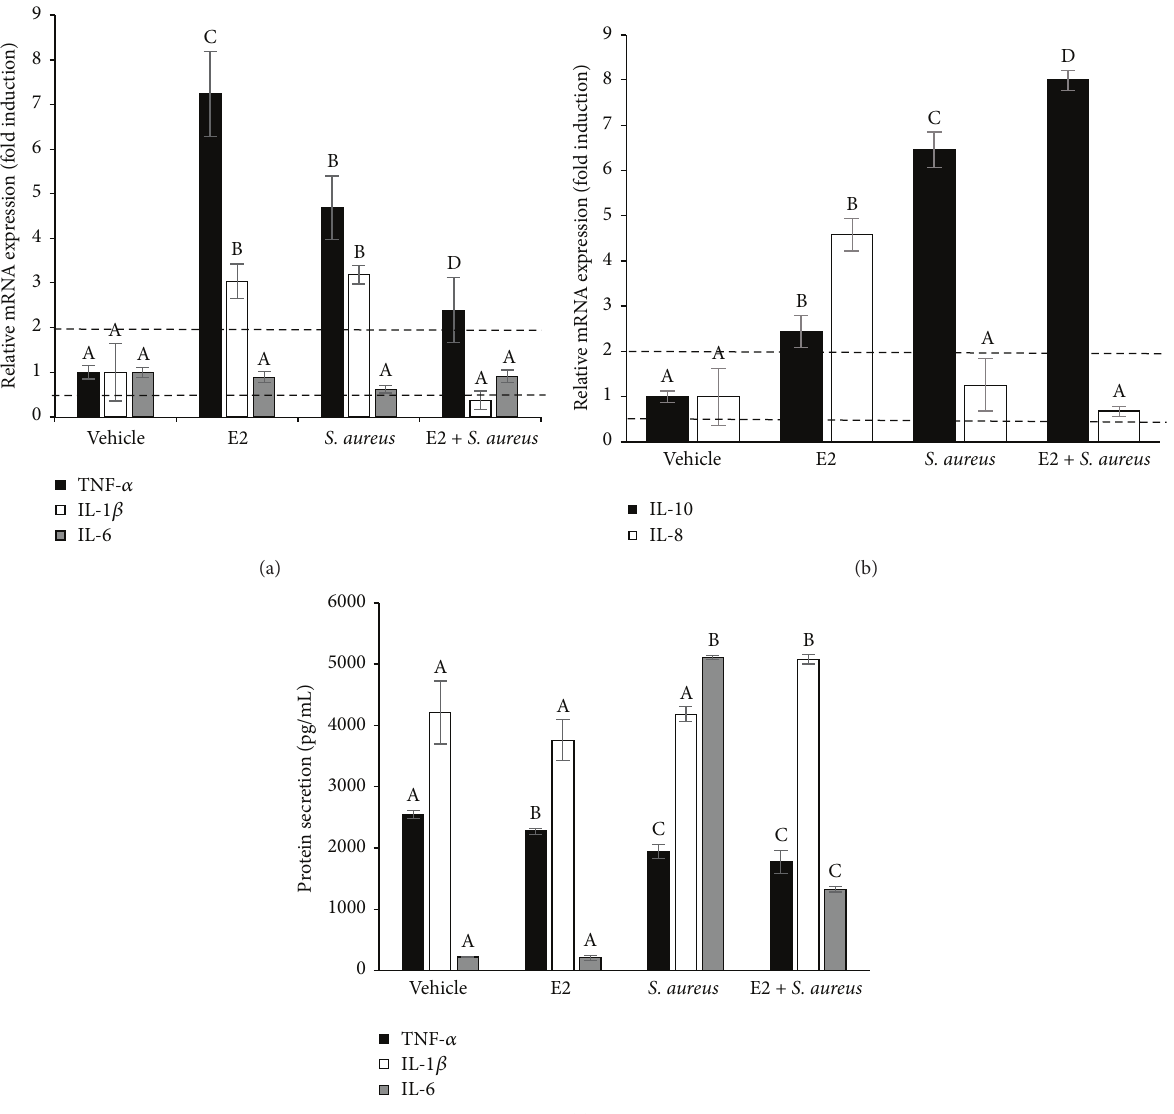
Figure 7: Expression of pro- and anti-inflammatory genes in bMECs treated with E2 and infected with S. aureus . (a) RT-qPCR analysis showing the mRNA expression levels of TNF- 𝛼 , IL-1 𝛽 , and IL-6. The bMECs were treated with 0.5 pg/mL of E2 for 24h and then challenged with S. aureus for 2 h. (b) RT-qPCR analysis showing the mRNA expression levels of IL-10 and IL-8. The bMECs were treated with 50 pg/mL of E2 for 24 h and then challenged with S. aureus for 2h. The data are presented as the ratio of the target gene expression compared with the expression level of GAPDH. Each bar shows the mean of triplicates ± SD of three independent experiments. Fold-change values greater than 2 or less than 0.5 were considered as significant differentially expressed mRNAs. (c) Concentrations of TNF- 𝛼 , IL-1 𝛽 , and IL-6 in culture medium of bMECs treated with 50 pg/mL of E2 for 24 h and then challenged with S. aureus for 2 h. The protein concentrations were determined by ELISA. Different letters above the bars indicate significant changes among the four treatments within the same gene or cytokine evaluated ( 𝑃 < 0.05 ). Vehicle: 1%